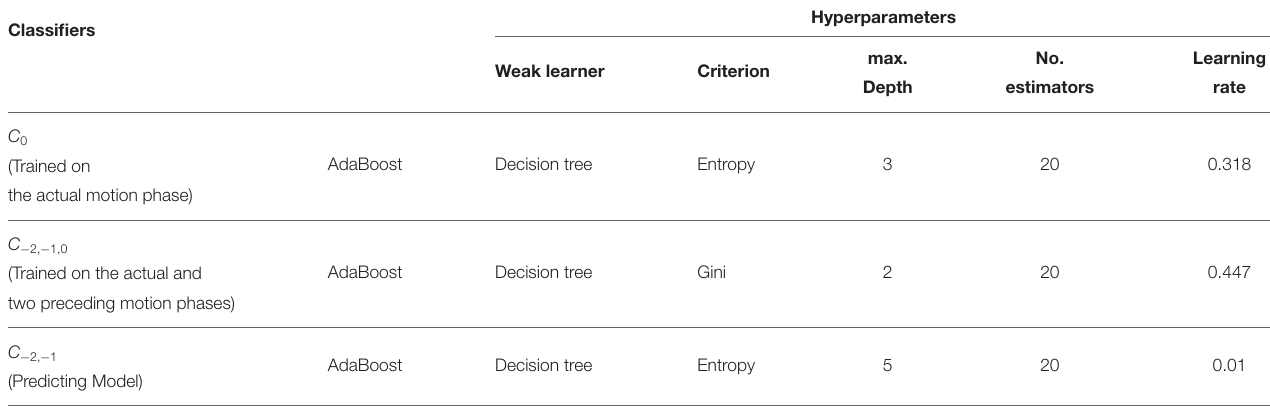
TABLE 4 | AdaBoost hyperparameters.